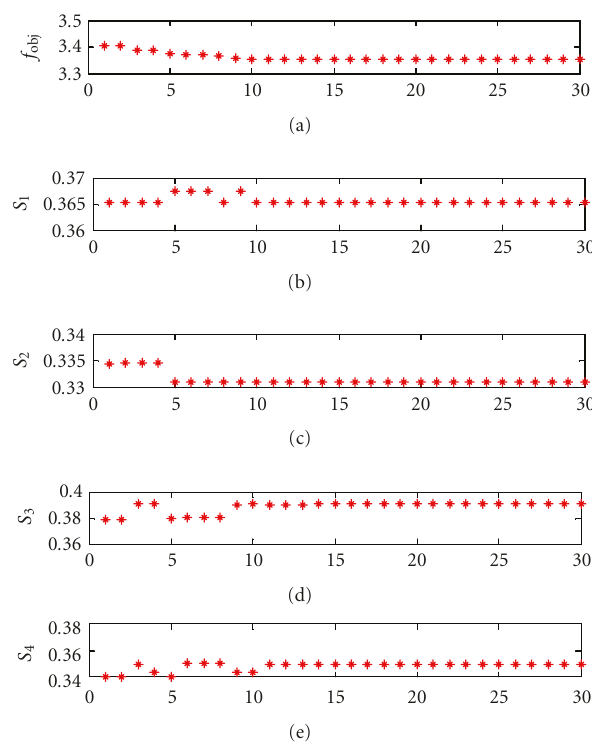
Table 3: Quantization steps from GA optimization of 10 test